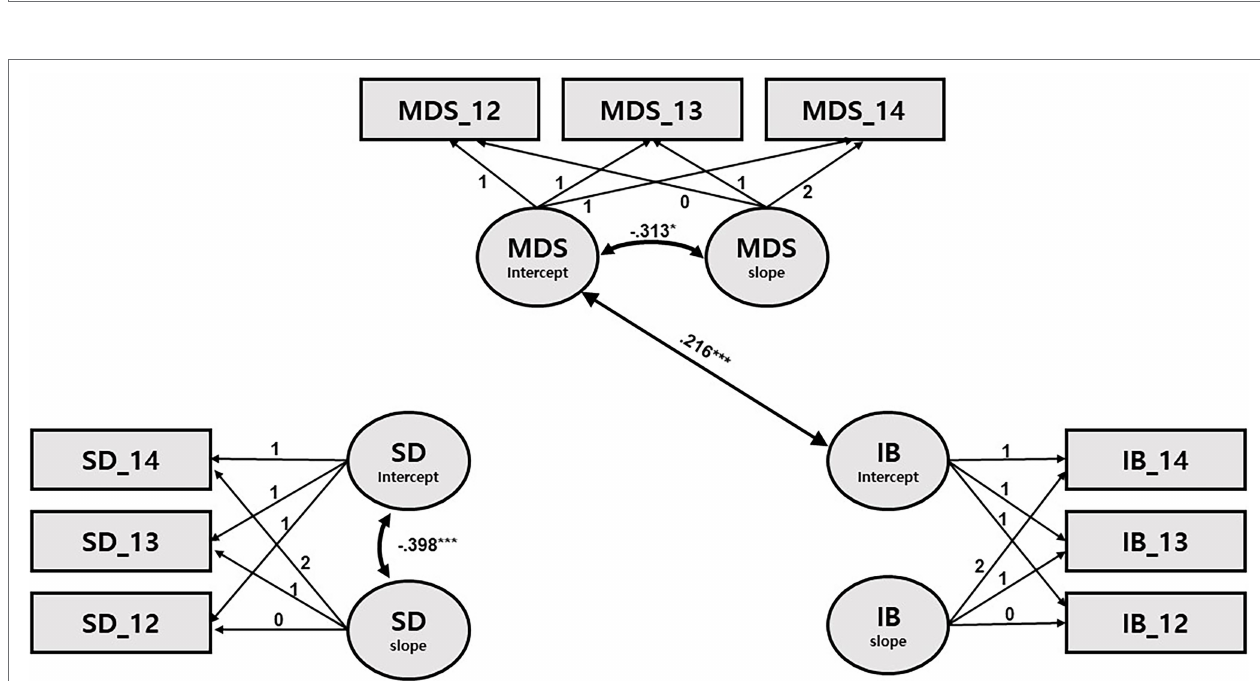
FIGURE 1 | Path diagram for latent growth modeling of sleep duration, externalizing behaviors, and maternal depressive symptoms. SD: sleep duration; EB: externalizing behaviors; and MDS: maternal depressive symptoms. Only significant path coefficients are shown. * p < 0.05, ** p < 0.001, and *** p < 0.001.